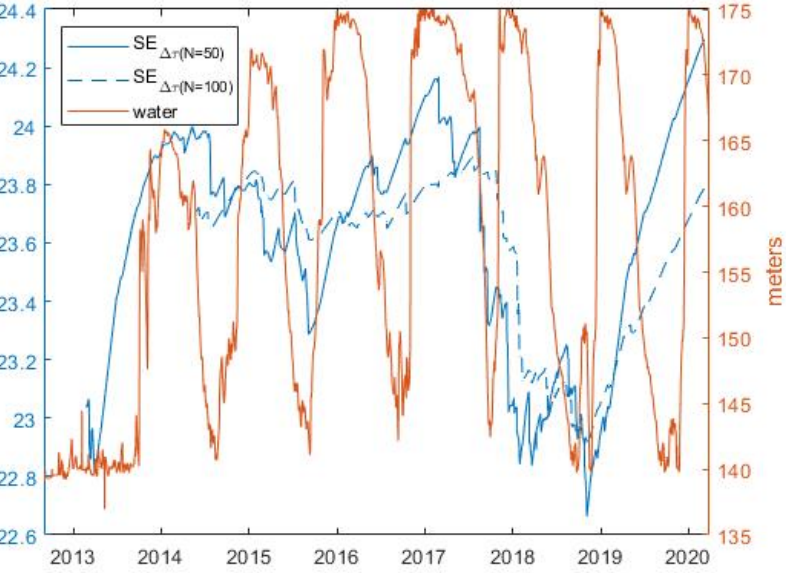
Figure 4. SE of Δ τ for the de-clustered seismic catalogue (blue) and water level (red). Two different lengths of moving windows have been selected for calculating SE: N = 50 (solid) and N = 100 (dashed).